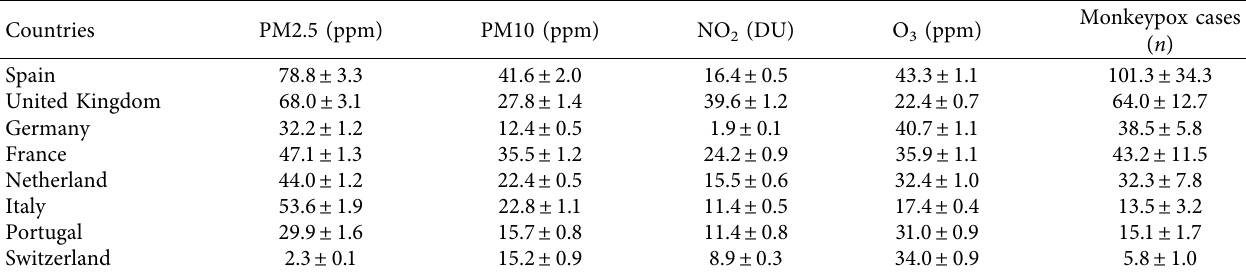
2 , and O 3 , and monkeypox cases in European countries.